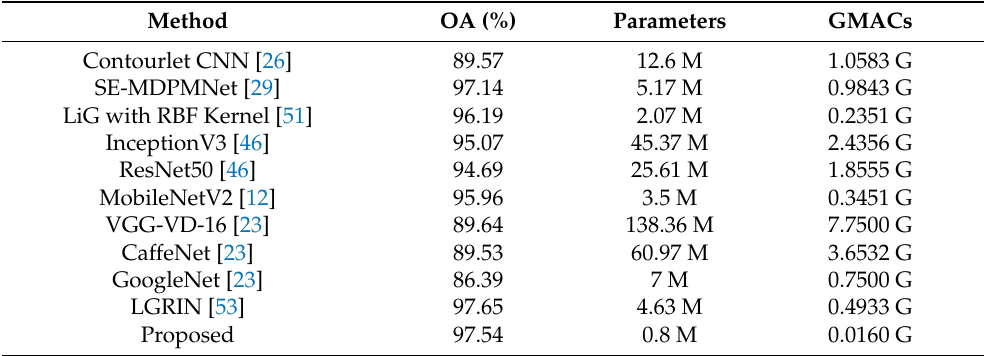
Figure 9. Confusion matrix of the LCNN-CMGF method on the NWPU45 (20/80) dataset. Table 11. Evaluation values of ten methods and the LCNN-CMGF method at the training ratio of 50% in the AID